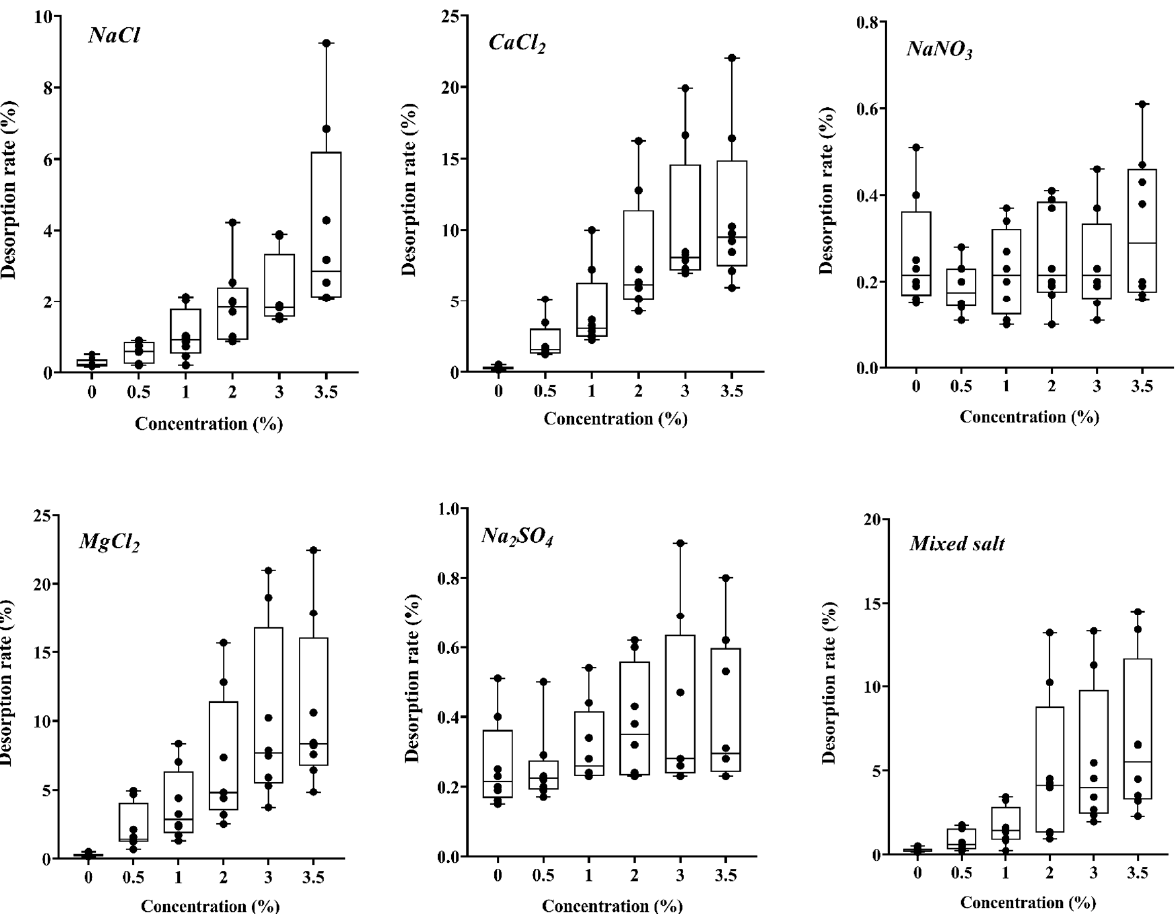
Figure 1. Percentages of Cd desorbed in the presence of different salts at different concentrations. The desorption rates of all samples under different concentrations of salt stress were calculated. For all the soil samples, the desorption rates corresponding to each salt con- centration gradient were 0.26% (0%), 1.04% (0.5%), 1.89% (1%), 3.72% (2%), 4.81% (3%), and 5.59% (3.5%). However, different soil samples had different sensitivities to salt stress. Taking MgCl 2 as an example, the highest Cd desorption rate at a salt concentration of 0.5% for the eight soil samples was 4.95%, and the lowest was 0.68%. At a salt concentration of 3.5%, the highest and lowest Cd desorption rates were 22.45% and 4.84%, respectively. The average desorption rates at salt concentrations of 0%, 0.5%, 1%, 2%, 3%, and 3.5% were 0.36%, 4.27%, 7.06%, 13.14%, 17.25%, and 17.61%, respectively. The differences between the maximum and minimum release for the soil samples increased as the salt con- centrations increased. The calculation result showed the mean of cadmium release rate under the stress of Na 2 SO 4 solution was higher than that of NaNO 3 . In general, high salt